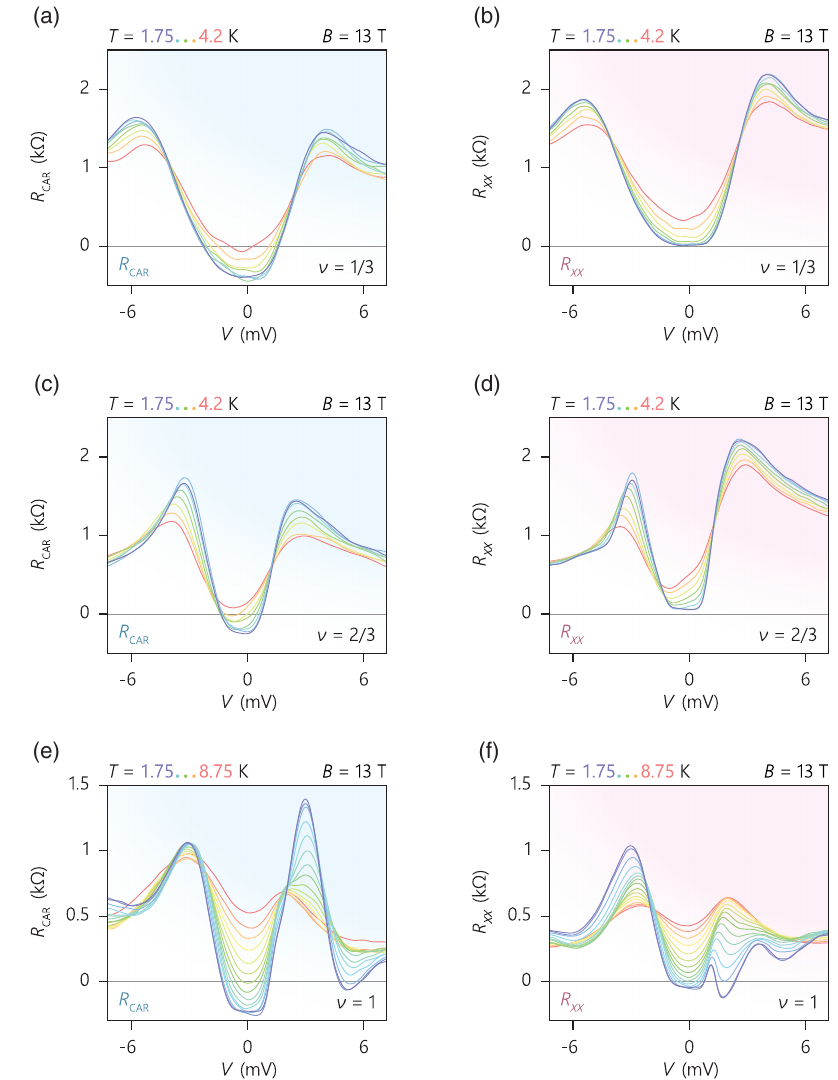
FIG. 11. Transport spectroscopy in device 2 (part 1). (a) – (f) R potential V (excitation) for different temperatures T . Crossed Andreev reflection ( R Increasing excitation and T suppress CAR by increasing bulk conductance for these fillings in this device. The features in (e) and (f) appearing at V ∼ 1 mV correspond to the magnon excitation [45,46], missing in other integer and fractional quantum Hall